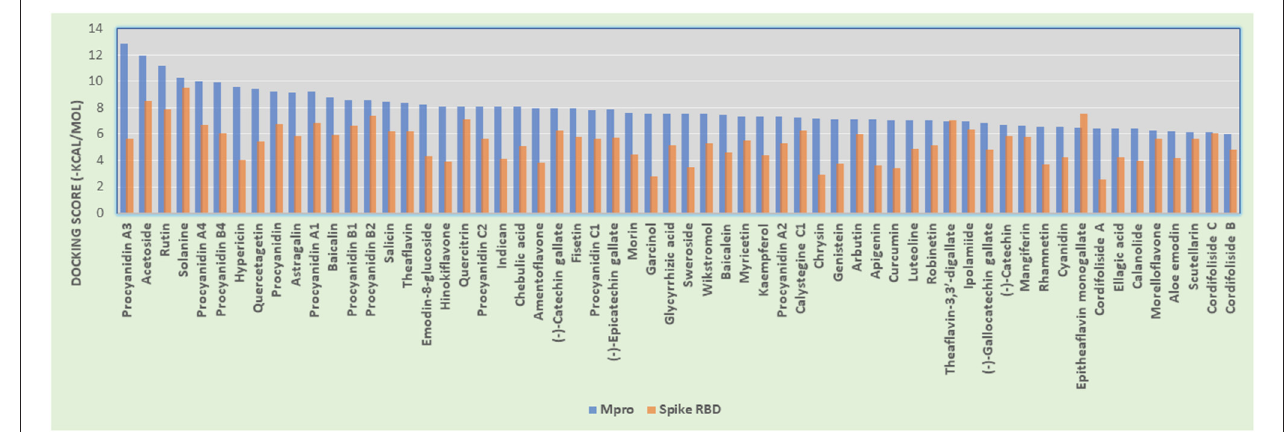
FIGURE 10 | Histogram showing the comparison between docking scores of phytoconstituents (listed in Table 1 ) against Mpro and Spike RBD.